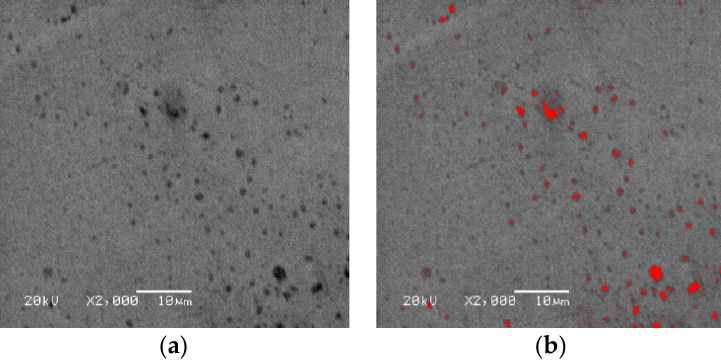
Figure 1. SEM photos of commercially pure titanium (TA1) ( a ) original morphology; ( b ) measurement